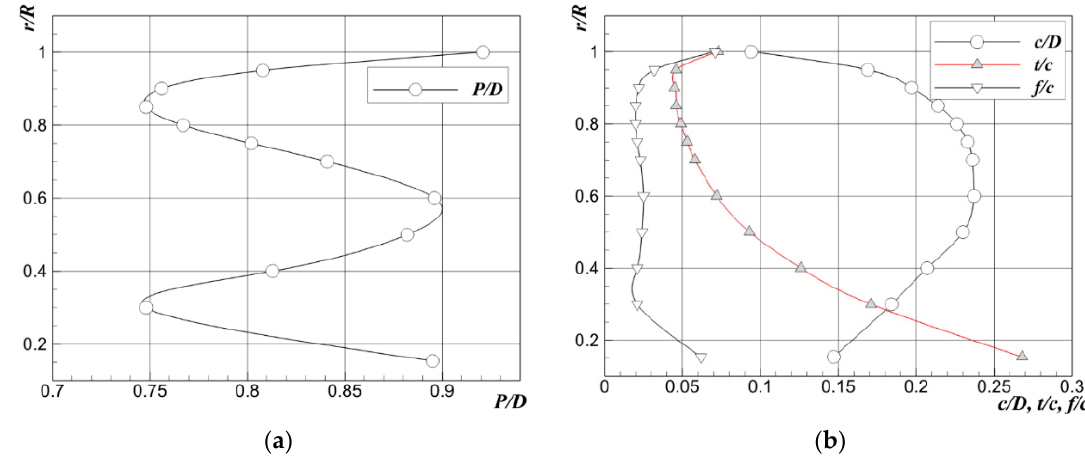
Figure 2. Variation of the geometric parameters with the relative radius. ( a ): pitch ratio; ( b ): relative chord, thickness and camber.